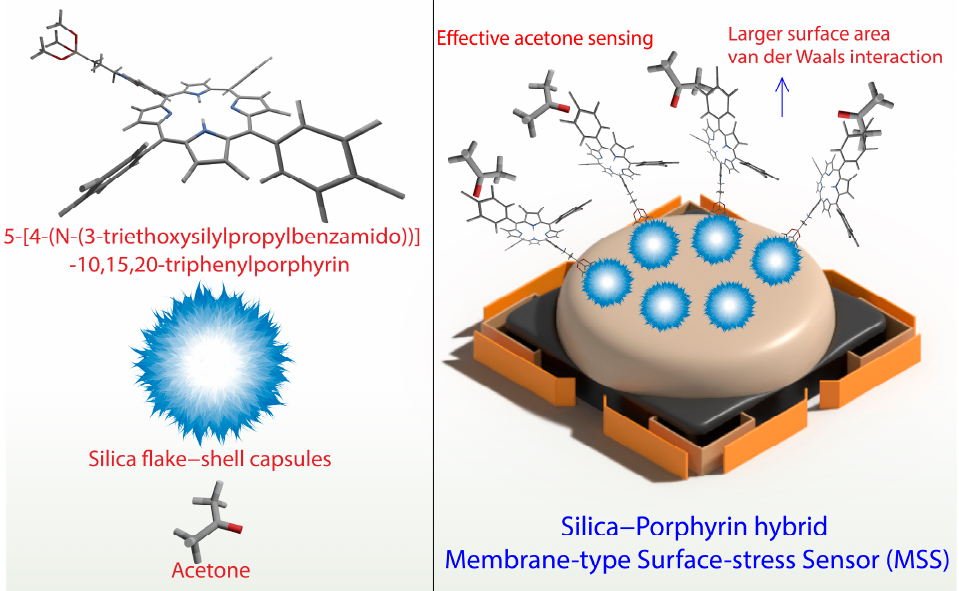
Figure 6. Silica–porphyrin hybrid assembly-based MSS system for effective detection of acetone.